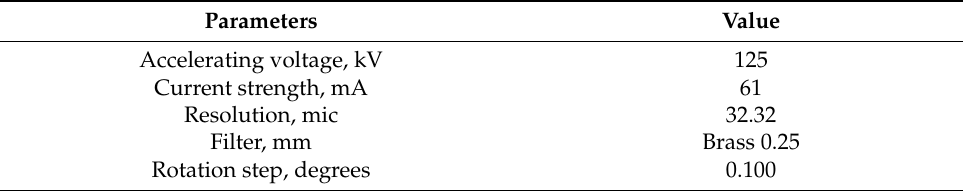
Table 3. Exposure parameter set of computed X-ray